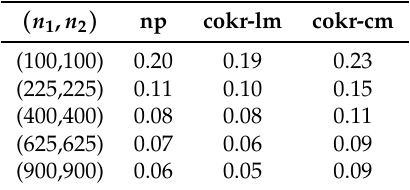
Table 4. AMSPE values obtained for several sample sizes n 1 and n 2 , for data drawn from random fields Z 1 and Z 2 with linear trends, derived from Gaussian processes V 1 and V 2 with exponential and Matérn semivariograms, respectively. For implementation of the cokriging approach, the dependence structures of V 1 and V 2 were estimated through the theoretical models and the trend estimation was addressed either by considering a constant model (cm) or a linear model (lm).